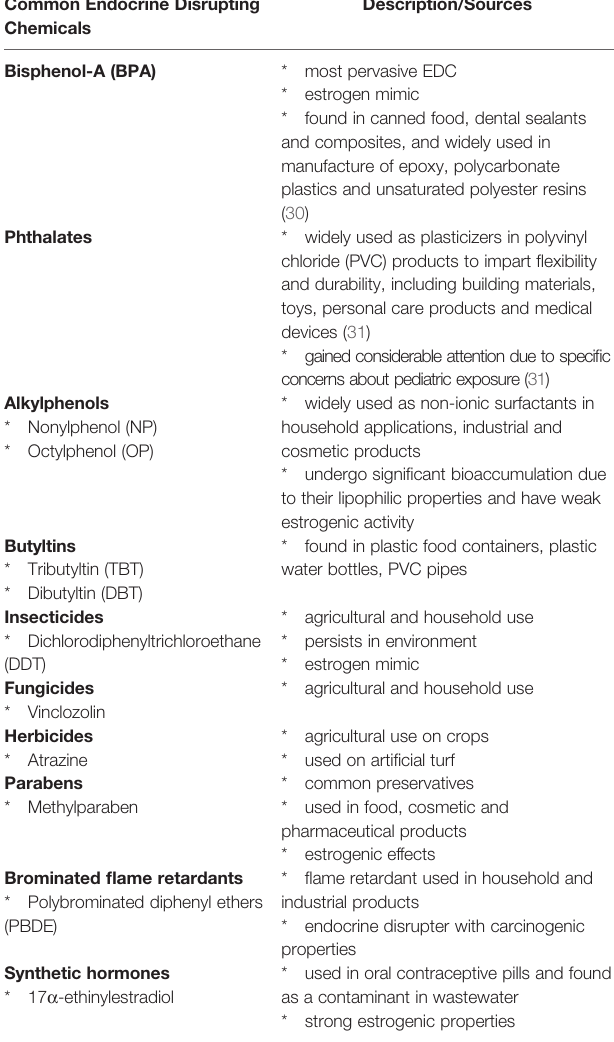
TABLE 1 | Common endocrine disrupting chemicals shown to impact the immune